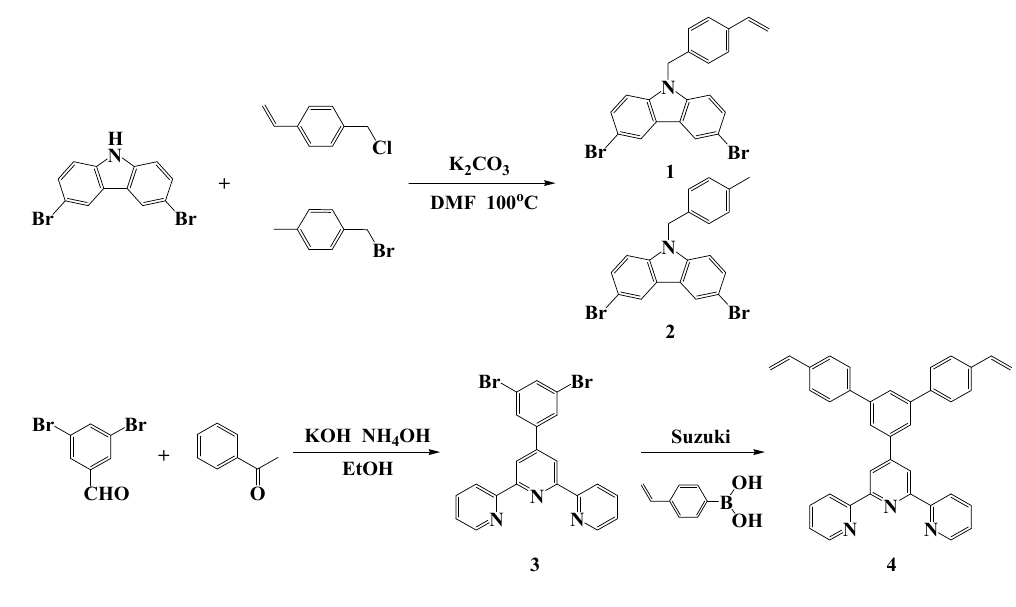
Scheme 1. Synthetic routes of